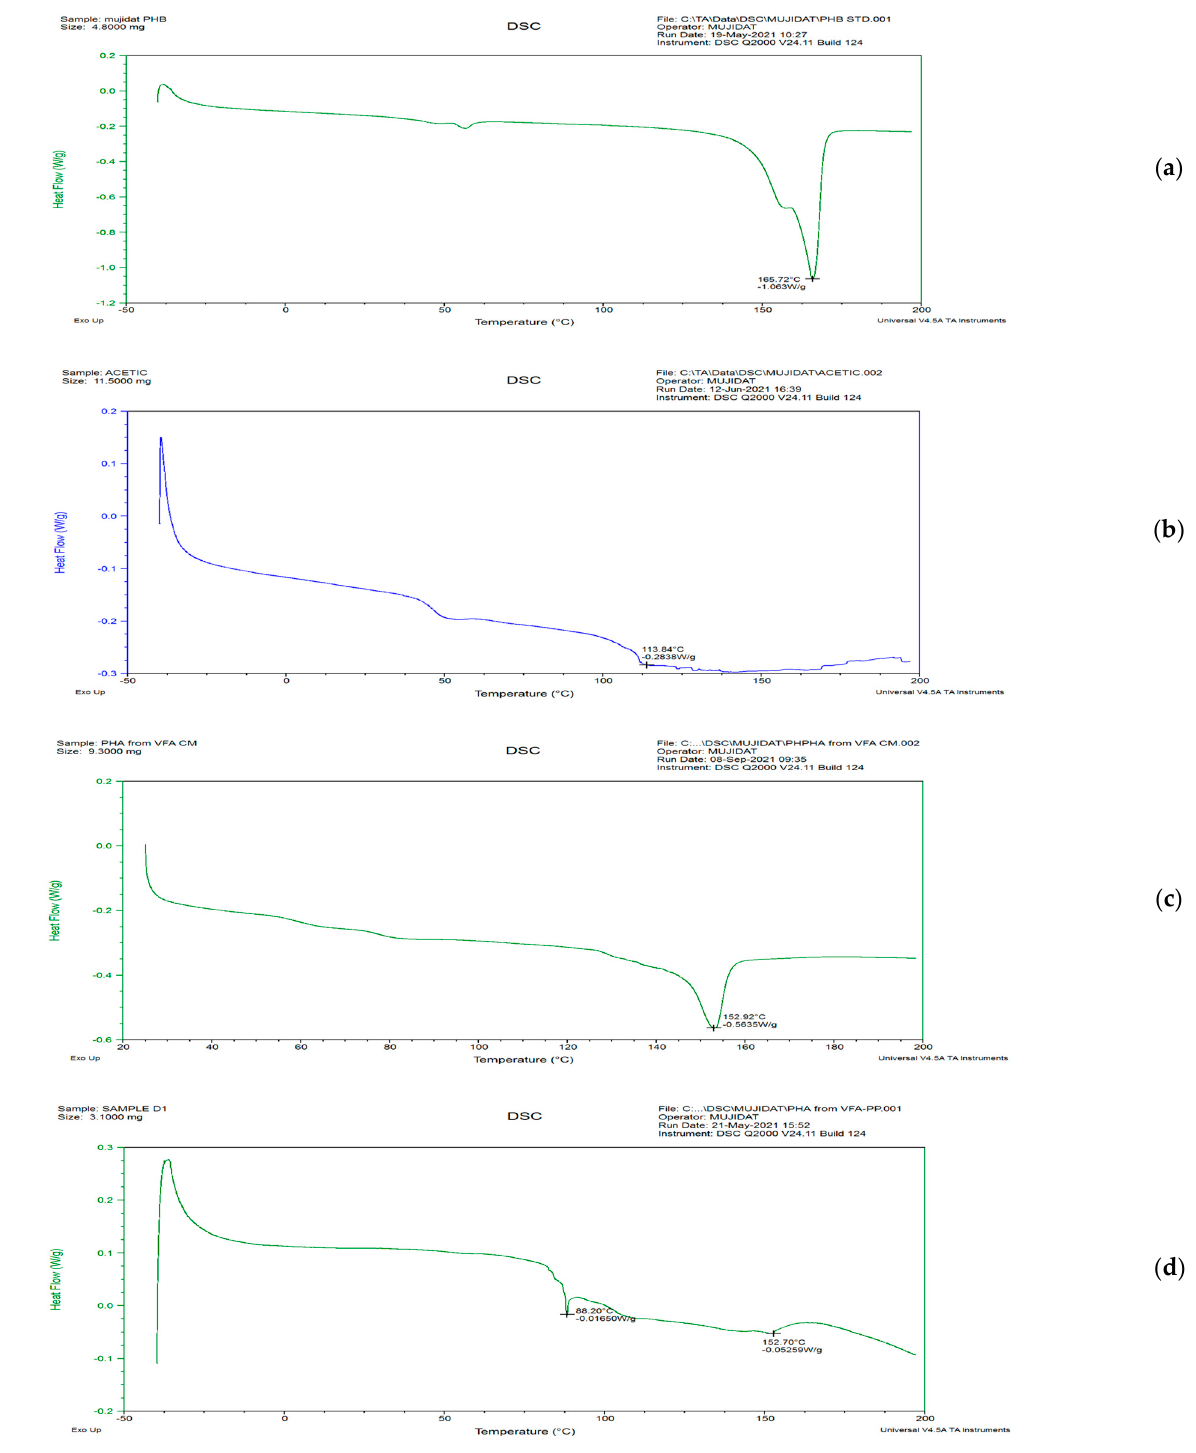
Figure 5. DSC thermograms of ( a ) commercial PHB ( b ) PHAs from synthetic VFAs ( c ) PHAs from volatile fatty acids from chicken manure and ( d ) PHAs from volatile fatty acids from potato peels. Table 4. Comparison of DSC data for produced biopolymers with commercial PHB.